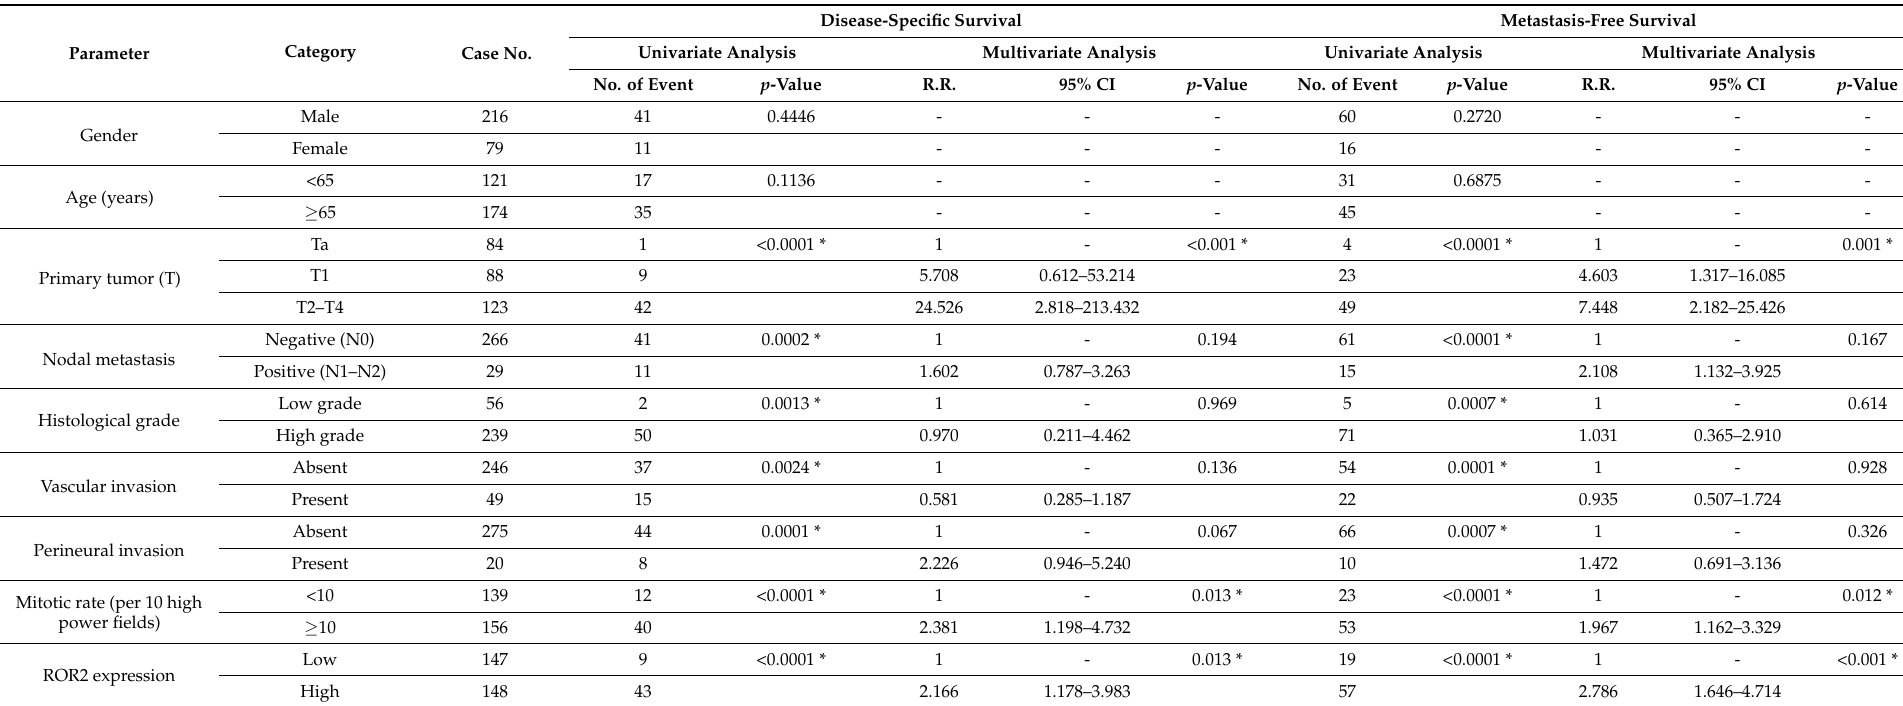
Table 4. Univariate log-rank and multivariate analyses for disease-specific and metastasis-free survival in urinary bladder urothelial